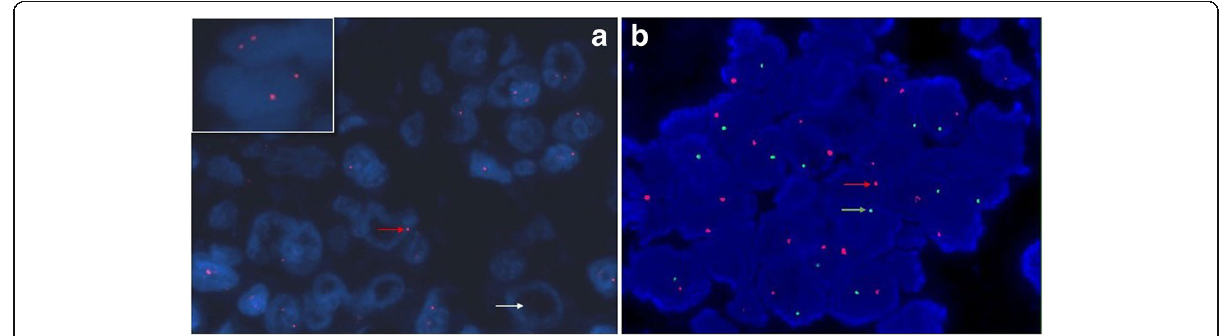
Fig. 3 Fluorescence in situ hybridization (FISH) analysis: a Deletion of SMARCB1/INI1 is evidenced by loss of one (red arrow) or both (white arrow) probe signals (red) in tumor nuclei, while two copies are retained in the nuclei of normal renal tubular epithelial cells (insert). b FISH analysis of sex chromosomes showed tumor cells had a male gonosomal complement (positive results for the X (green arrow) and Y chromosomes (red arrow), consistent with donor